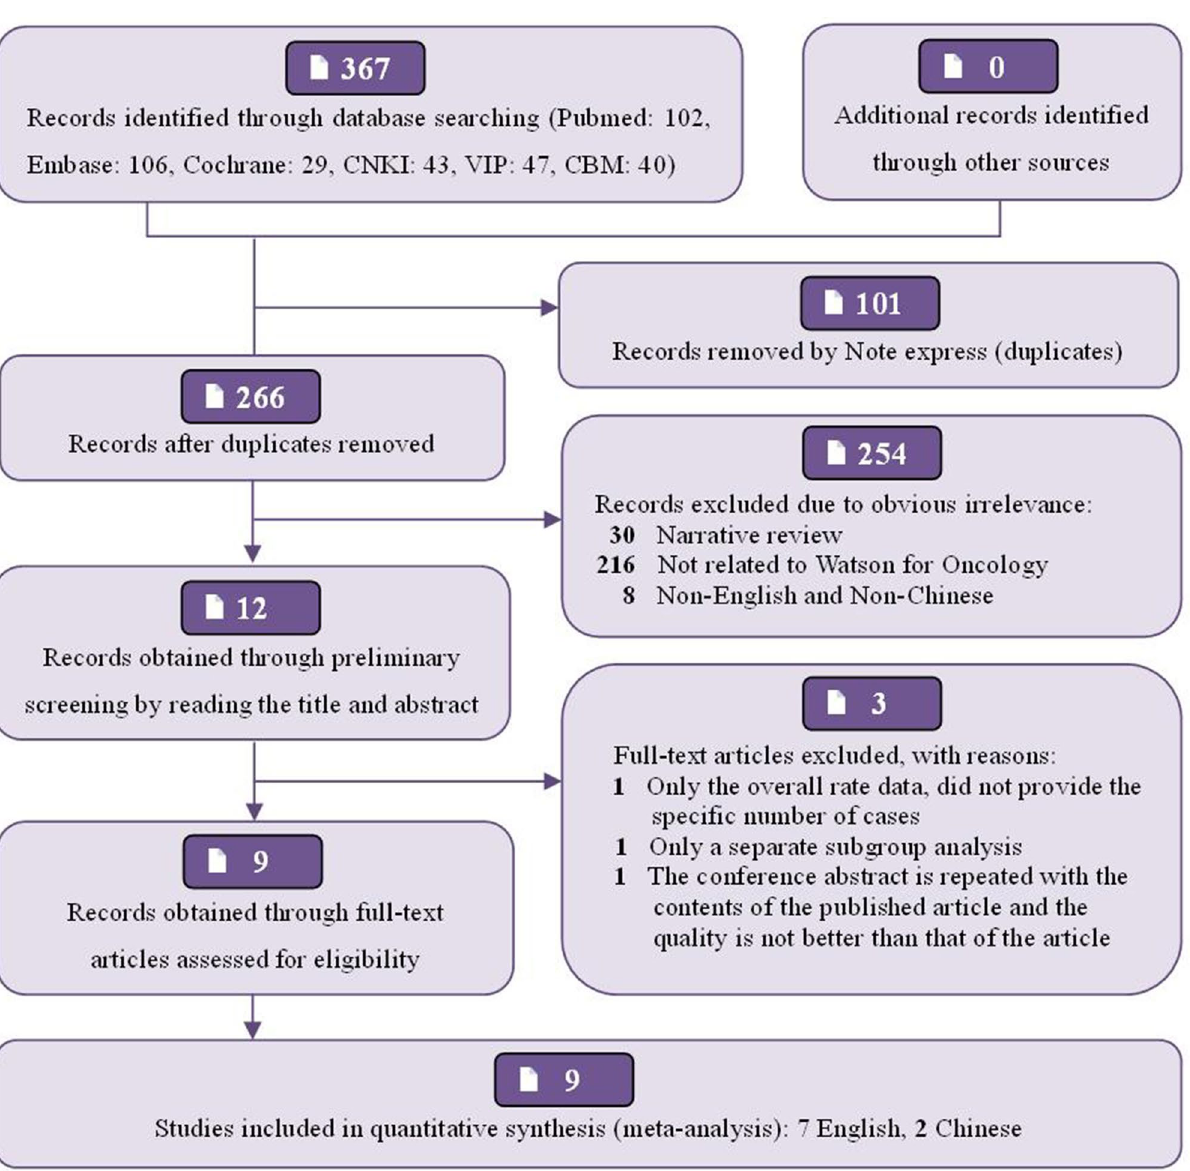
Figure 1. Flow diagram of the study selection